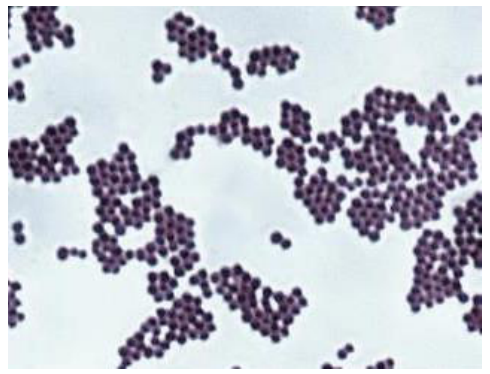
Figure 1. Gram’s staining of Staphylococcus aureus (1000×).